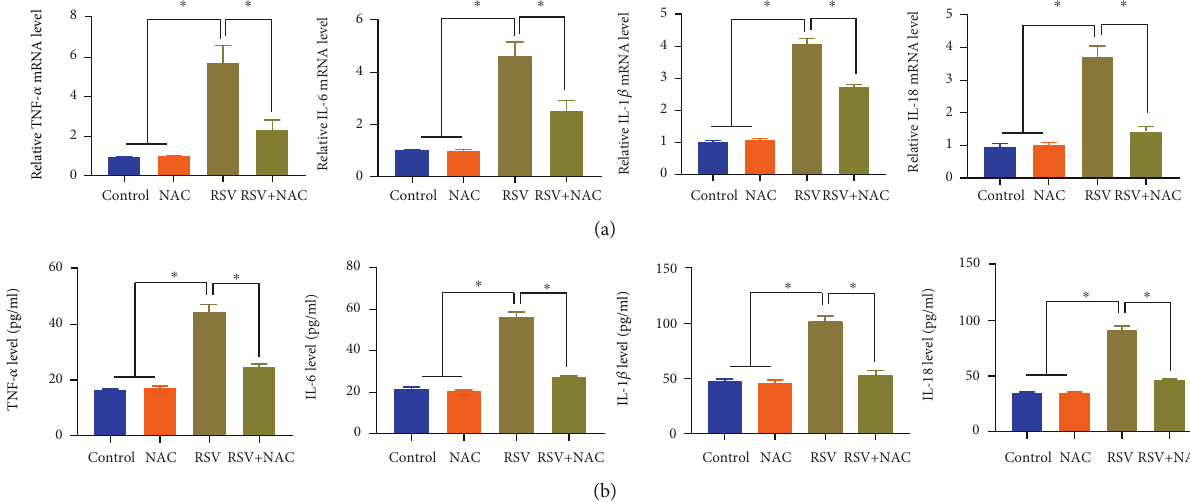
Figure 2: Anti-in fl ammatory properties of NAC in RSV-infected BEAS-2B cells. Quantitative real-time PCR (a) and ELISA (b) were performed to examine the production of in fl ammatory cytokines, TNF- α , IL-6, IL-1 β , and IL-18, from BEAS-2B cells. ∗ indicates p < 0 : 01